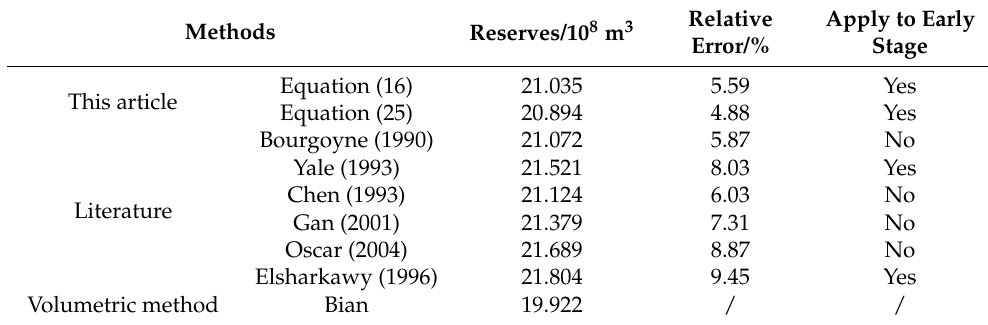
Table 4. Comparison of dynamic reserves estimation results of different methods.